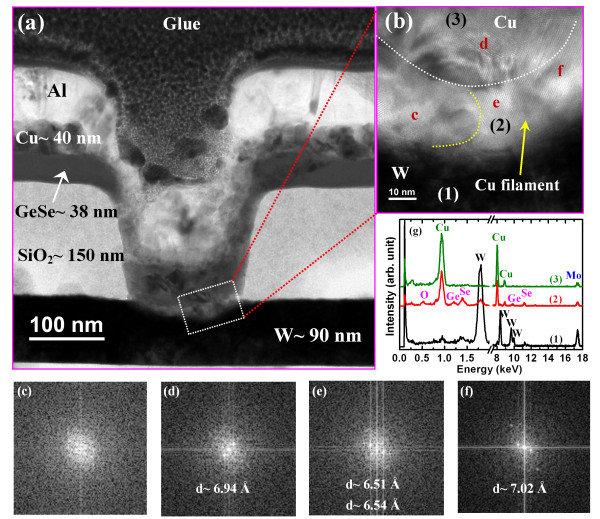
Cuz+ ion migration and filament formation. (a) HRTEM image of an Al/Cu/Ge0.2Se0.8/W resistive memory device after 6 × 103 P/E cycles and the device kept in SET condition. (b) The diameter of the Cu filament is approximately 30 nm. (c) Amorphous Ge0.2Se0.8 film is observed at the without-filament region by FFT. (d) FFT in Cu electrode. (e) to (f) Crystalline Cu filament is observed. (g) EDX analysis at the points indicated in (b). The numbers (1), (2), and (3) indicated in (b) correspond to the EDX analysis positions.